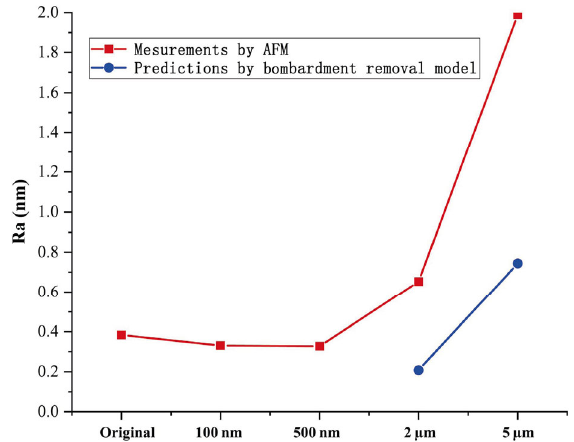
Fig. 8 Surface roughness of original silicon surface and silicon surfaces polished by SiO 2 particles with a diameter of 100 nm, 500 nm, 2 µm, and 5